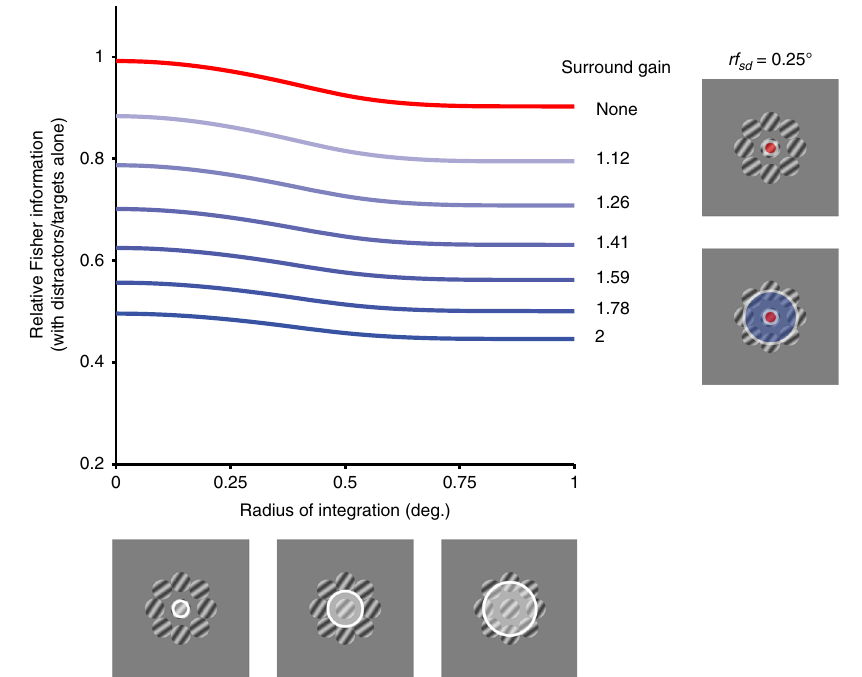
Fig. 8 Information loss as a function of spatial scale of integration. Fisher information (with distractors compared to targets alone) in a model population of independent neurons, as a function of increasing radius of spatial integration. Populations with excitatory receptive fi elds (red, s.d. = 0.25°) show a slight information loss as neurons with offset receptive fi elds are included. Including divisive surrounds in the receptive fi elds (blue, s.d. = 1.0°), leads to greater relative information loss with distractors, which scales with the gain of the surround (blue shading; values at right). Source data are provided as a source data fi